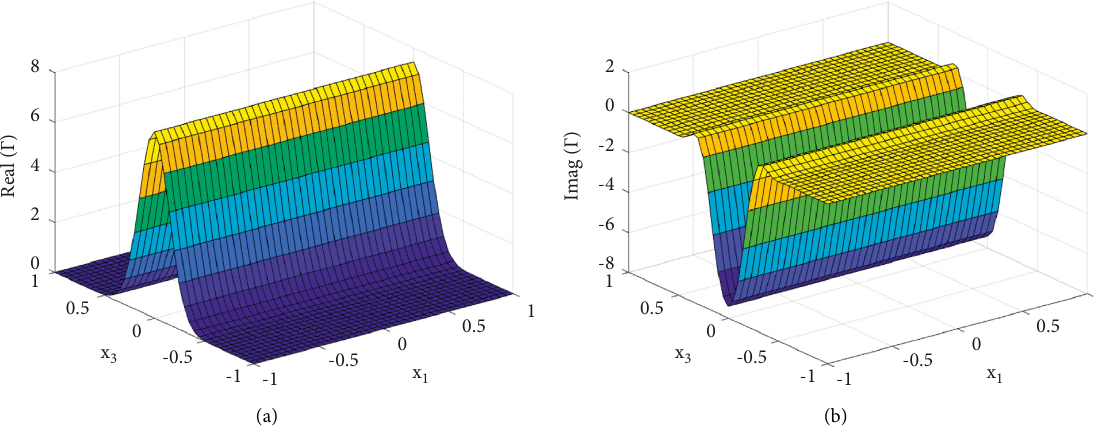
Figure 1: The real part of the complex solution (31) (a) denotes the bright soliton solution with x imaginary part of the complex solution (31) (b) denotes the dark soliton solution with x